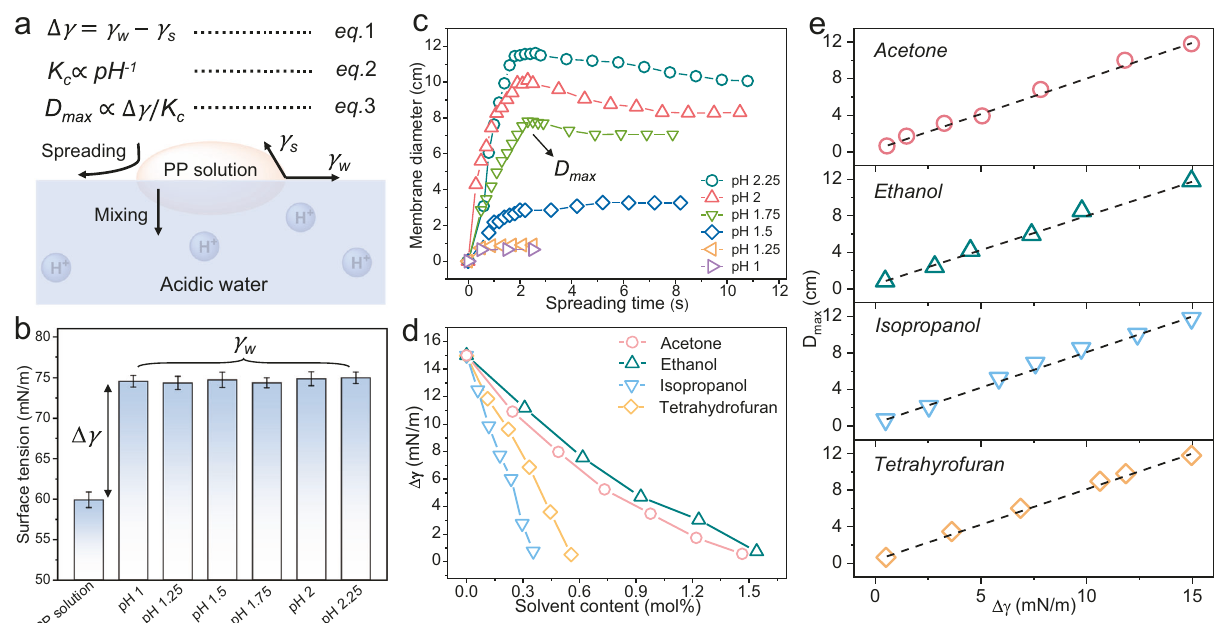
Fig. 4 Veri fi cation of the SWOW mechanism. a A schematic illustration of the effect of surface tension difference ( Δ γ ) and PEI-PSSNa complexation ( K c ) on maximum diameter ( D max ) of the PPMs. b Surface tension of PSSNa-PEI solution, and water (pH: 1, 1.25, 1.5, 1.75, 2, 2.25). Error bars: standard deviation. c Dependence of the of PPMs diameter on time when PEI-PSSNa solution was placed on water with different pH. d Dependence of Δ γ on the amount of organic solvents added in water. e Dependence of D max of PPM2.25 on Δ γ . Note: Δ γ = γ w − γ s . Note: PP solution means PEI-PSSNa solution.